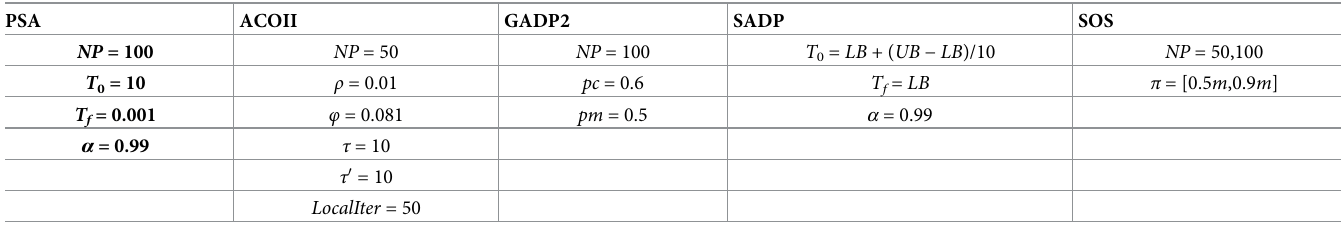
Table 2. Parameter settings for the five